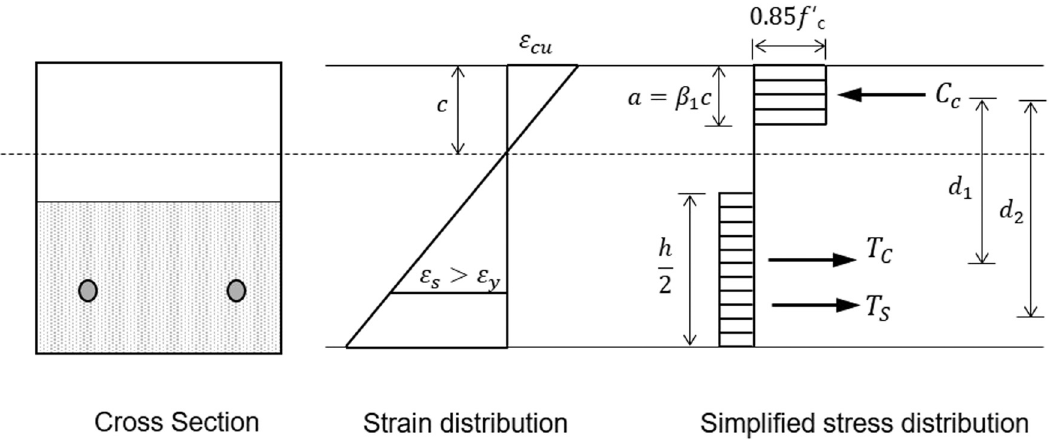
Figure 7: Strain and stress distributions of the SMA fi ber – embedded beam with tensile wires at the ultimate state.